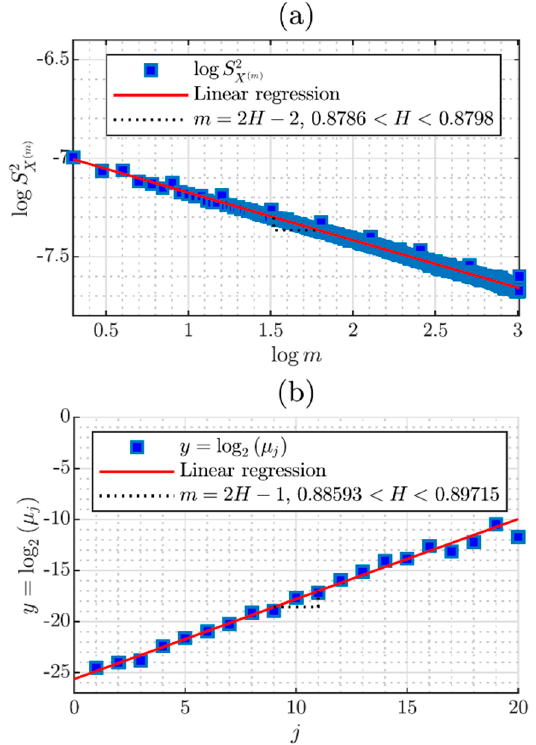
Figure 10. ( a ) Variance-time diagram (VT) diagram for the trace synthesized with the β -MWM algorithm. ( b ) LD for the trace synthesized with the β -MWM algorithm.